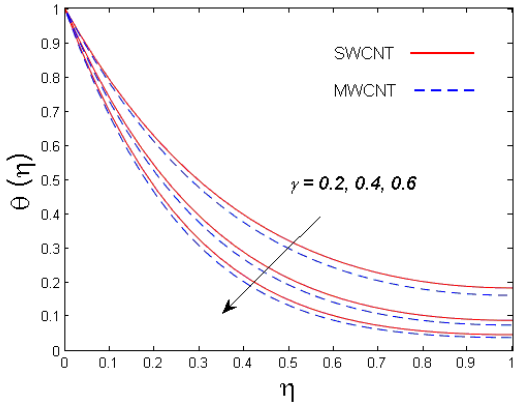
Figure 10. The illustration of γ versus θ ( η ).